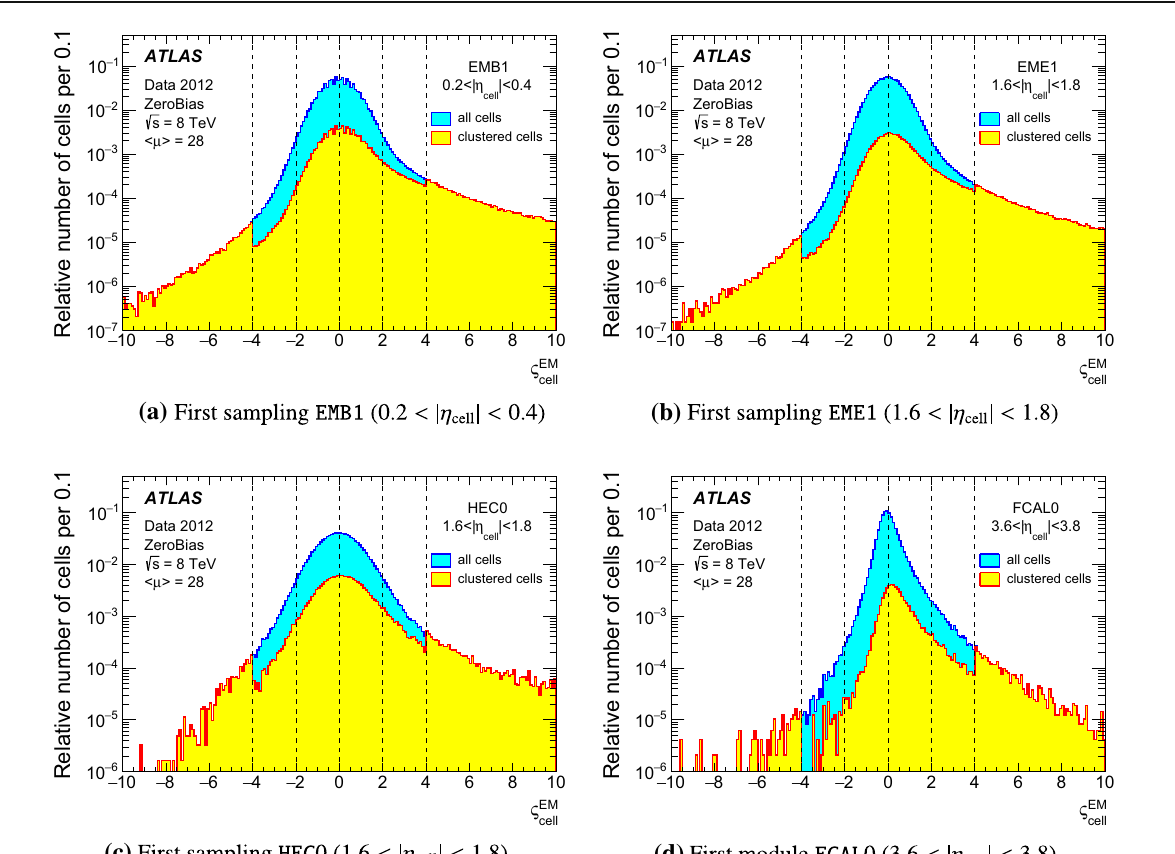
Fig. 5 Signal significance ( ς EM end-cap calorimeter ( EMEC ), c the first sampling of the hadronic LAr ) distributions for all cells ( blue / cyan ) cell end-cap calorimeter ( HEC ), and d the first module of the LAr forward and for cells after the noise suppression in the topological cell clus- calorimeter ( FCAL ). The spectra are extracted from 2012 zero-bias data tering is applied ( red / yellow ), in selected sampling layers of the LAr √ s = 8TeVwithanaveragenumberofpile-upinteractions (cid:7) μ (cid:8) = 28. at calorimeters: a the first sampling of the central electromagnetic LAr calorimeter ( EMB ), b the first sampling of the electromagnetic LAr The dashed lines indicate S = ± 4, N = ± 2, and P = 0